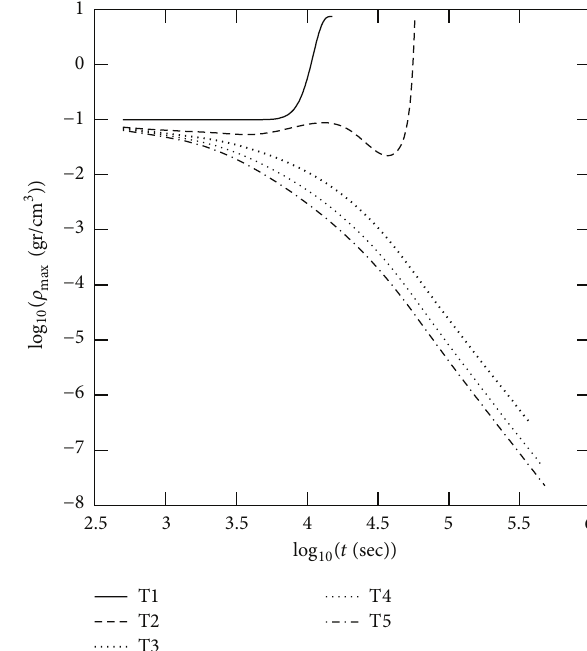
Figure 5: Radial distribution of SPH particles for the T models against the radial bin.